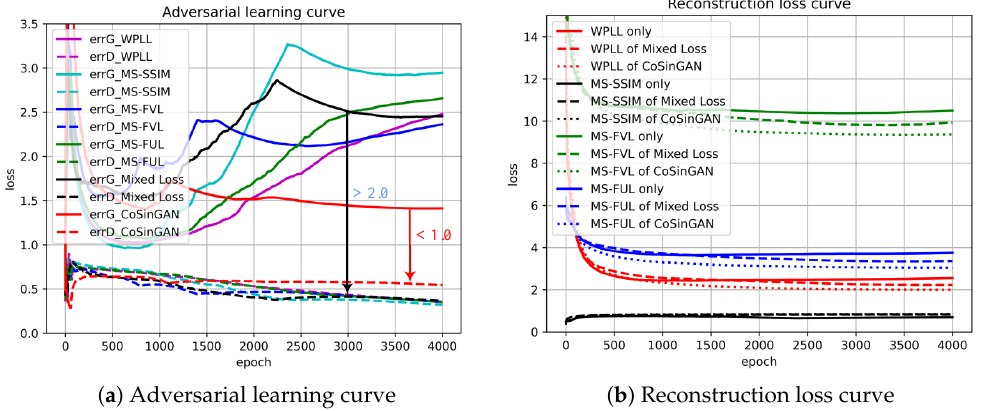
Figure 7. The learning curves of CoSinGAN trained with different reconstruction loss functions at the scale of 256 × 256. We plot the moving average of loss values for better